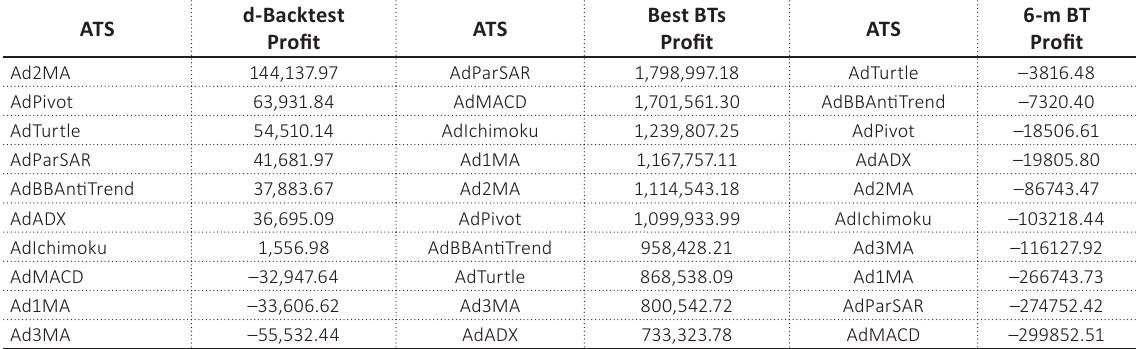
Table B5. Total results for